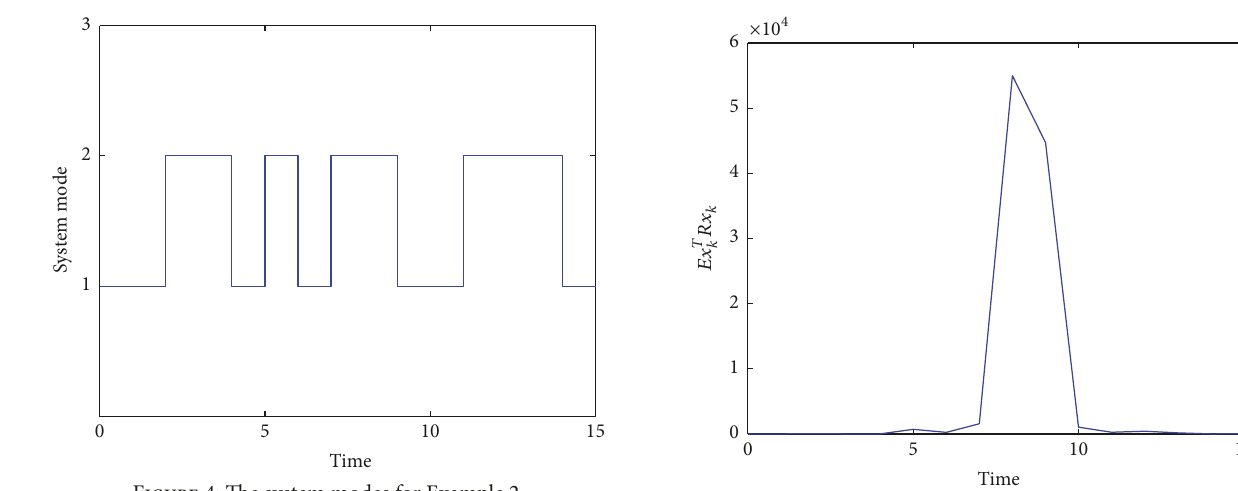
Figure 4: The system modes for Example 2.